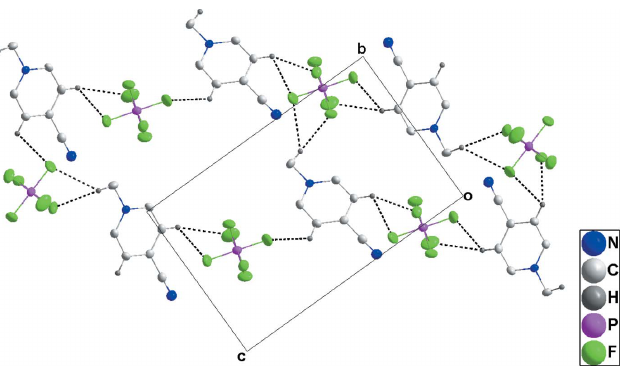
Figure 8 View of two adjacent cation–anion chains in 3 along the a -axis direction with C—H (cid:2)(cid:2)(cid:2) F hydrogen bonds shown by black dashed lines.